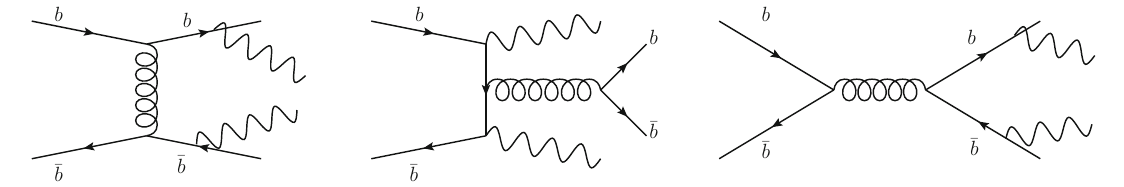
Fig. 7 Sample of tree-level diagrams that are only present in the five-flavor scheme and not in the four-flavor scheme